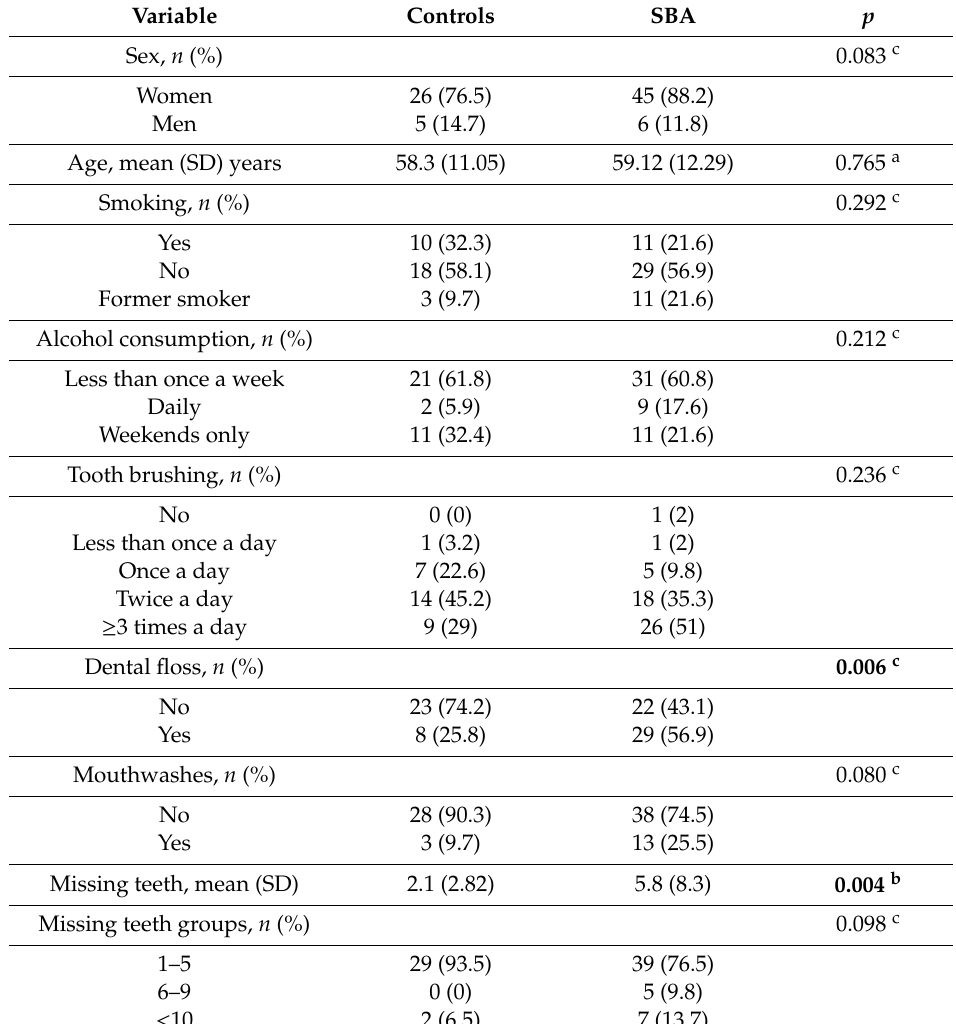
Table 1. General characteristics of